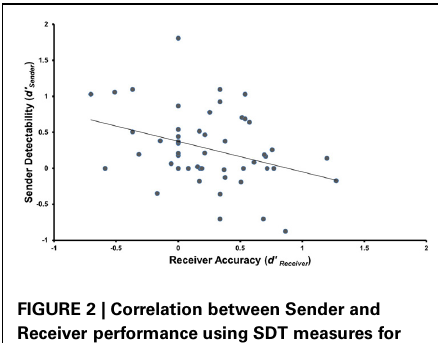
FIGURE 2 | Correlation between Sender and Receiver performance using SDT measures for ) and Sender Receiver Accuracy ( d (cid:2) receiver ) ( r = − 0 . 348, p = 0 . 006, Detectability ( d (cid:2) sender d = 0 .